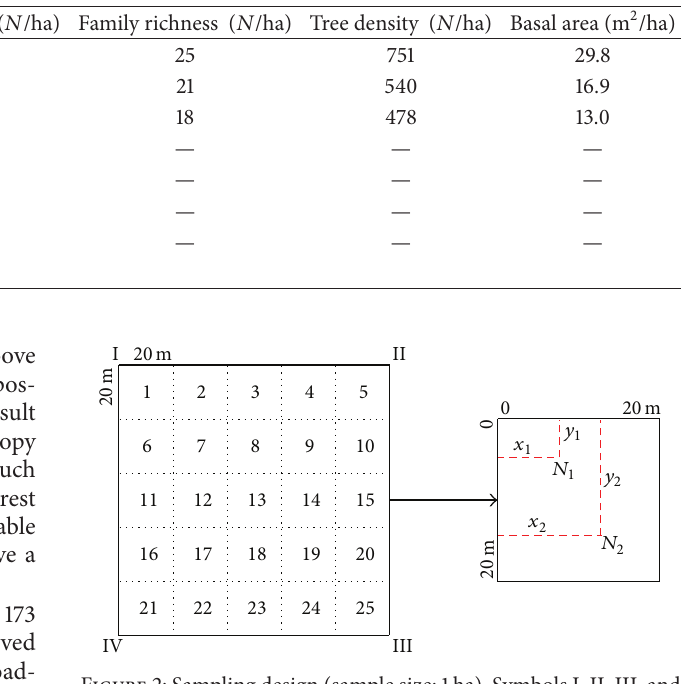
Figure 2: Sampling design (sample size: 1ha). Symbols I, II, III, and IV are the four corners of the sampled plot. 25 subplots (20 m × 20 m) were set up in order to measure the coordinates of all trees with DBH ≥ 5cm. 𝑁 1 ( 𝑥 1 , 𝑦 1 ); 𝑁 2 ( 𝑥 2 ,𝑦 2 ) are the tree coordinates